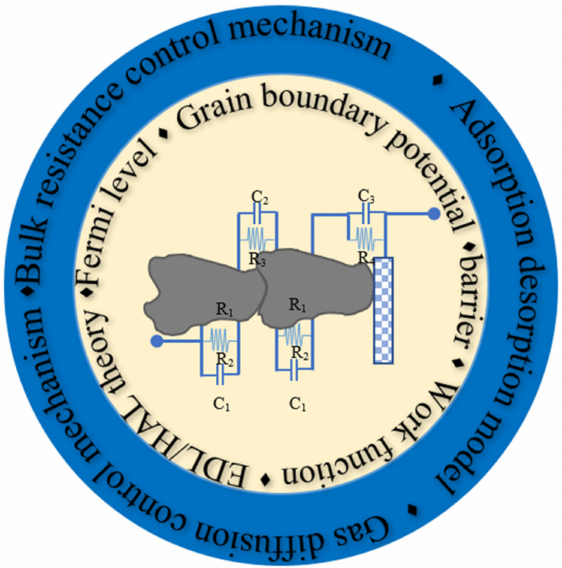
Figure 1. Schematics of the sensing-mechanism